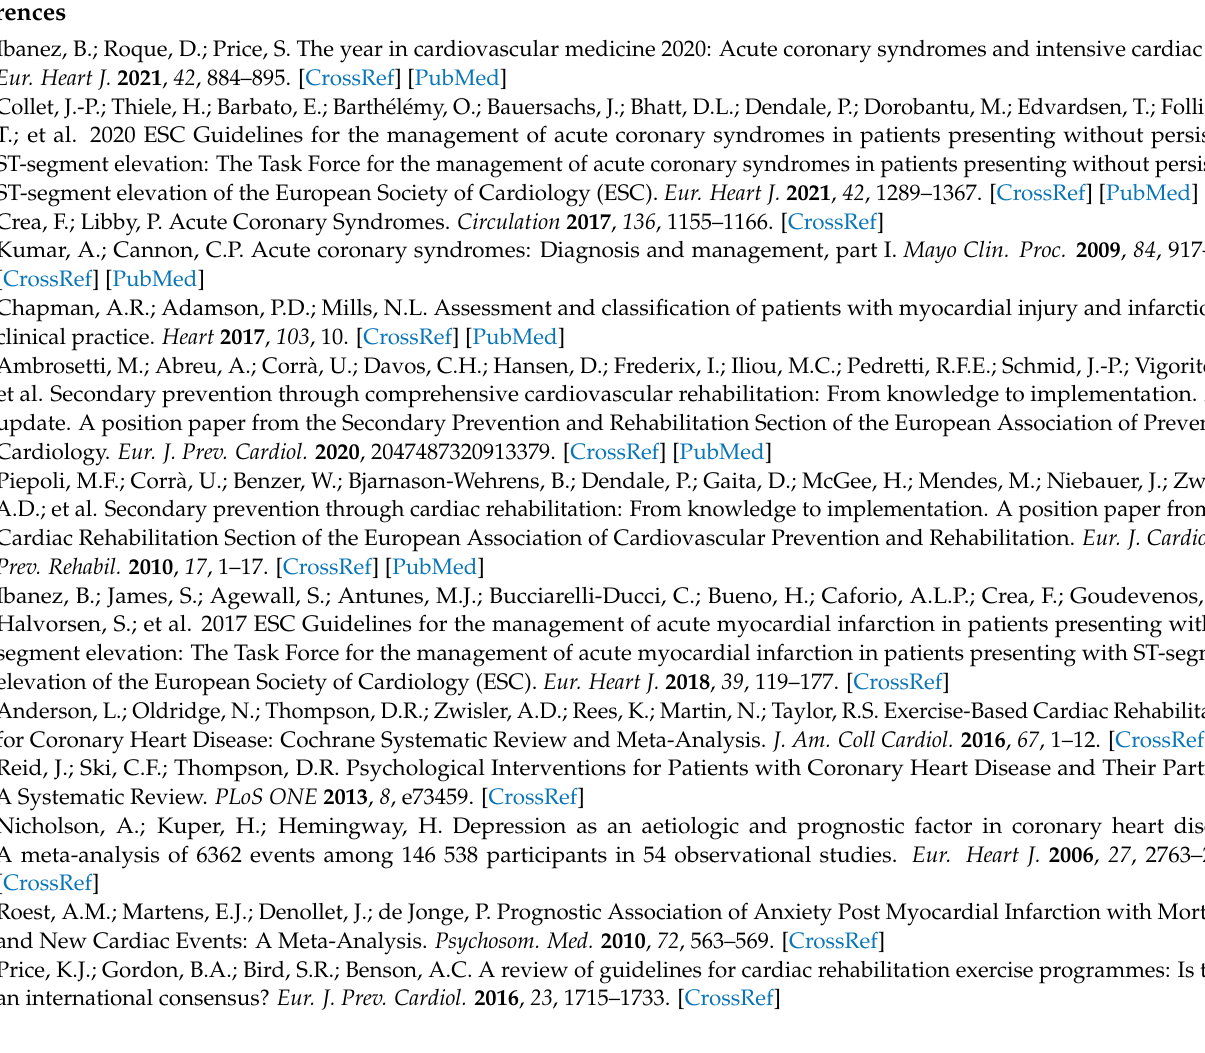
Figure S1: Risk of bias across studies; Table S3: Effects of interventions: summary of findings for the main comparison of psychological intervention with or without other rehabilitation compared to control for acute coronary